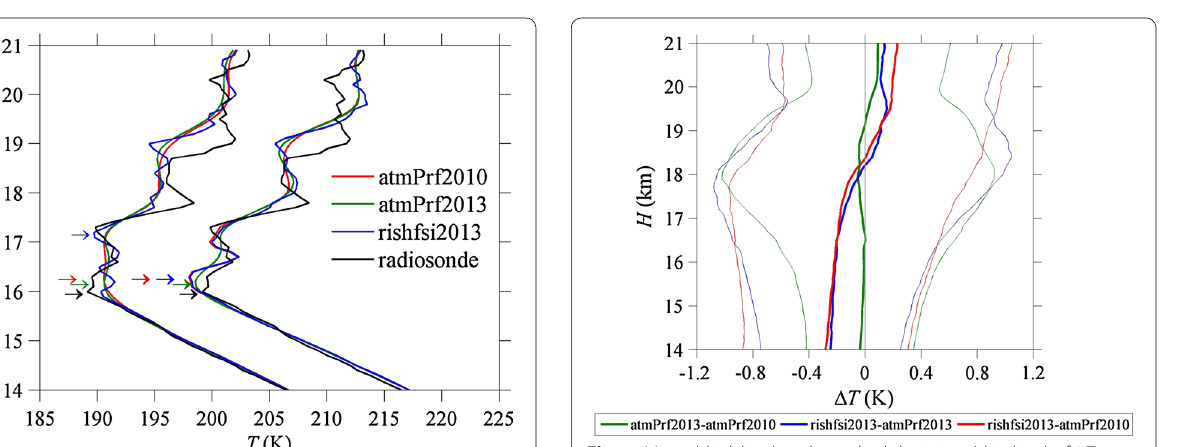
Fig. 4 Mean ( thick lines ) and standard deviation ( thin lines ) of ∆ T among the GPS-RO datasets for combinations of atmPrf2013–atm- Prf2013 ( green ), rishfsi2013–atmPrf2013 ( blue ) and rishfsi2013–atm- Prf2010 ( red